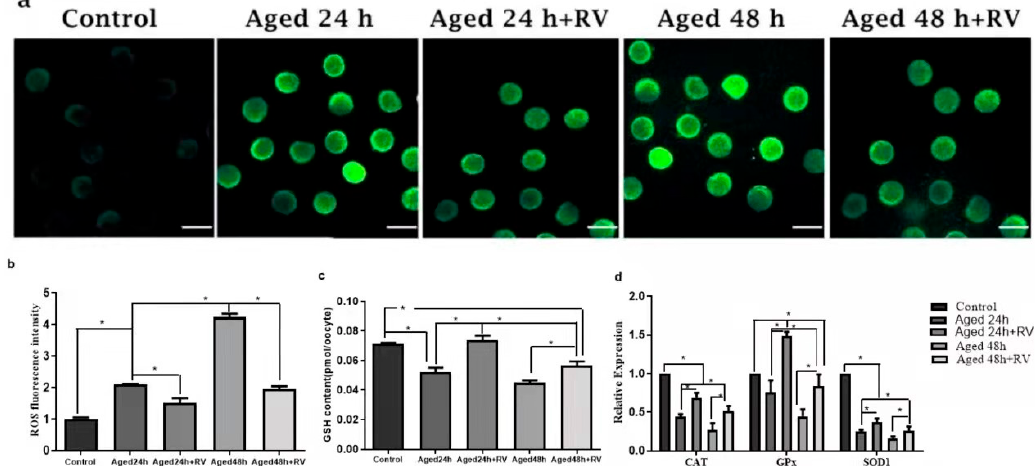
Figure 4. RV alleviates the oxidative stress in aged porcine oocytes. ( a ) The representative images of ROS in aged porcine oocytes. ( b , c ) The graphs showing quantified intracellular levels of ROS and GSH in aged porcine oocytes. ( d ) The graph showing relative mRNA expression of oxidative stress related (CAT , GPX , and SOD1) genes in aged porcine oocytes. ROS levels were quantified by relative fluorescence intensity in porcine oocytes, scale bar = 280 μ m. Each experiment was independently repeated at least three times. Significant difference (* p < 0.05).